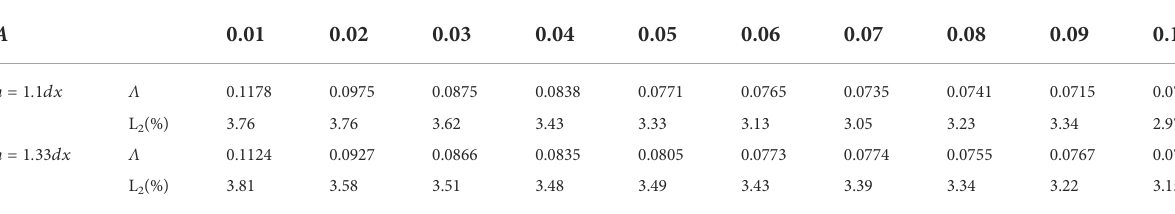
TABLE 2 In fl uence of A on particle distribution and numerical error in Xu ’ s